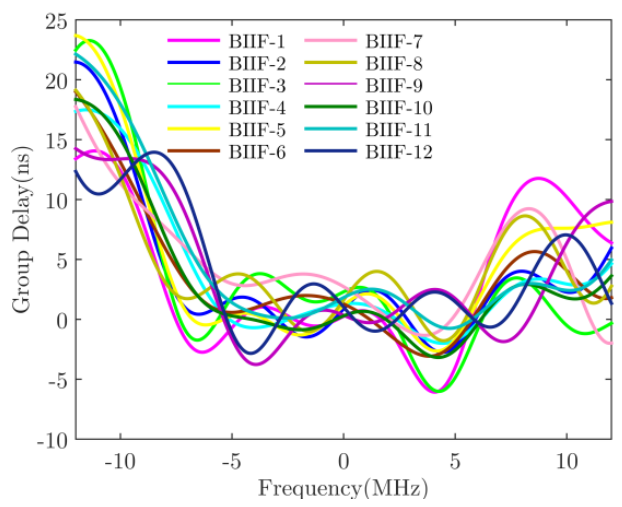
Figure 10. BIIF-5 group delay characteristic.